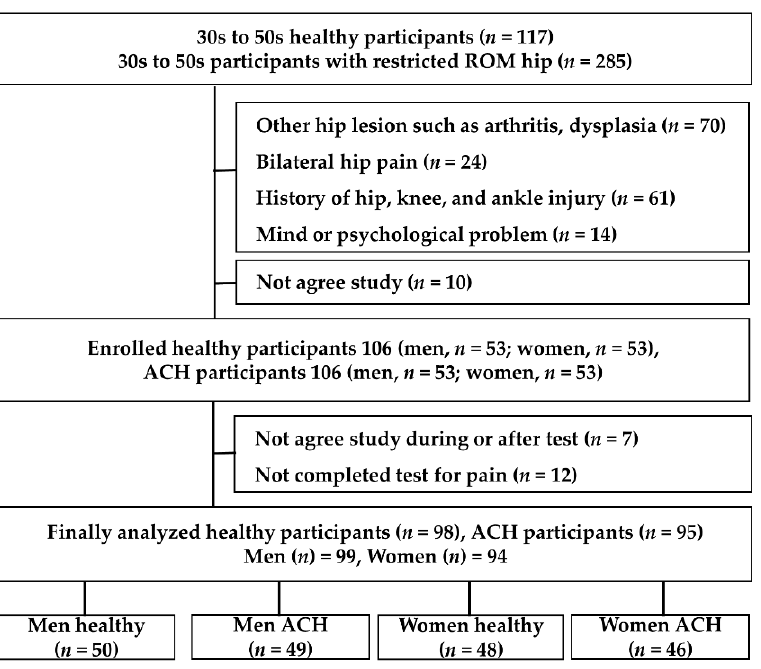
Figure 2. Participant’s exclusion and inclusion process.